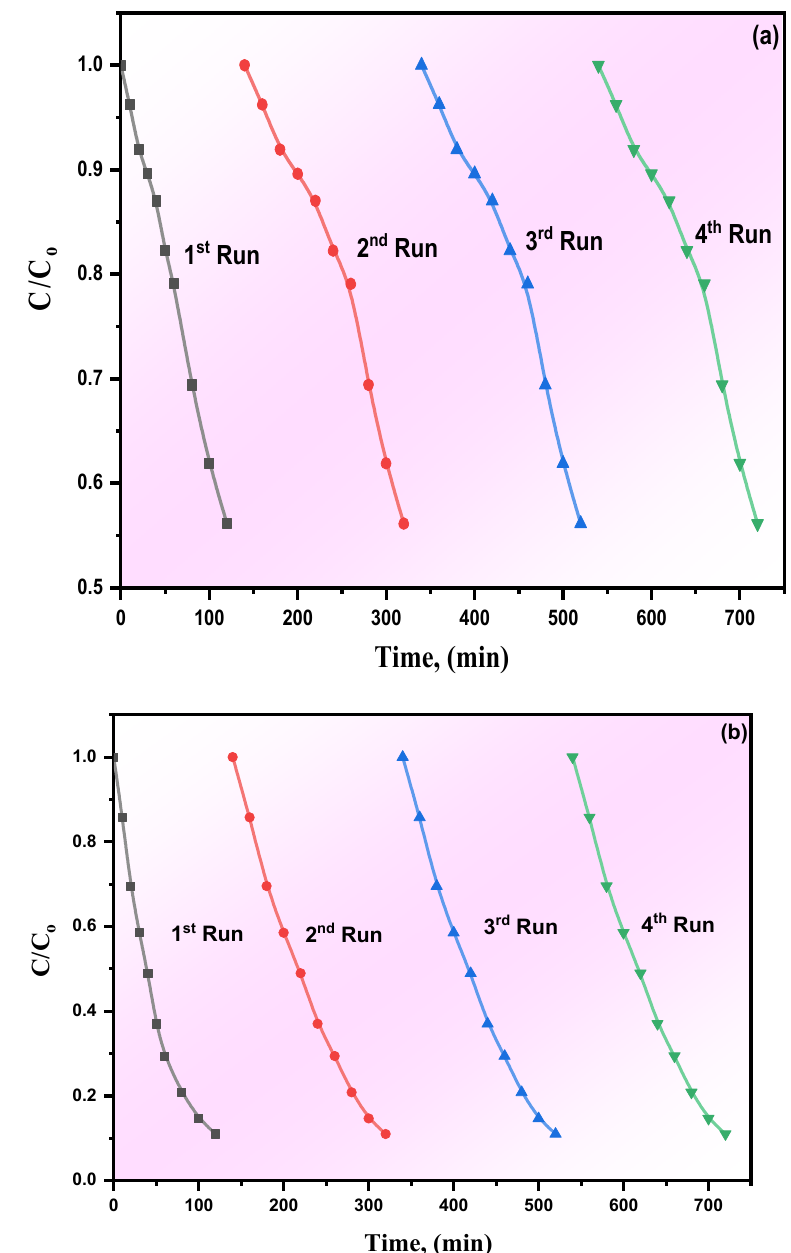
Figure 7. The recycling process for pure g-C 3 N 4 and its WO 3 /g-C 3 N 4 nanocomposites in photodeg- radation of ( a ) MB, ( b ) phenol. dation of ( a ) MB, ( b )